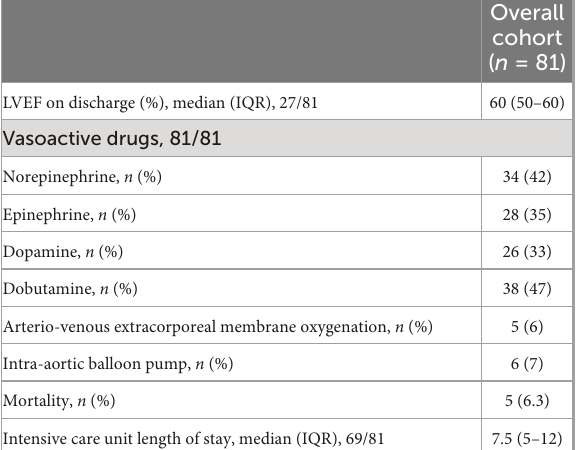
TABLE 2 Characteristics and outcomes of whole post-operative takotsubo